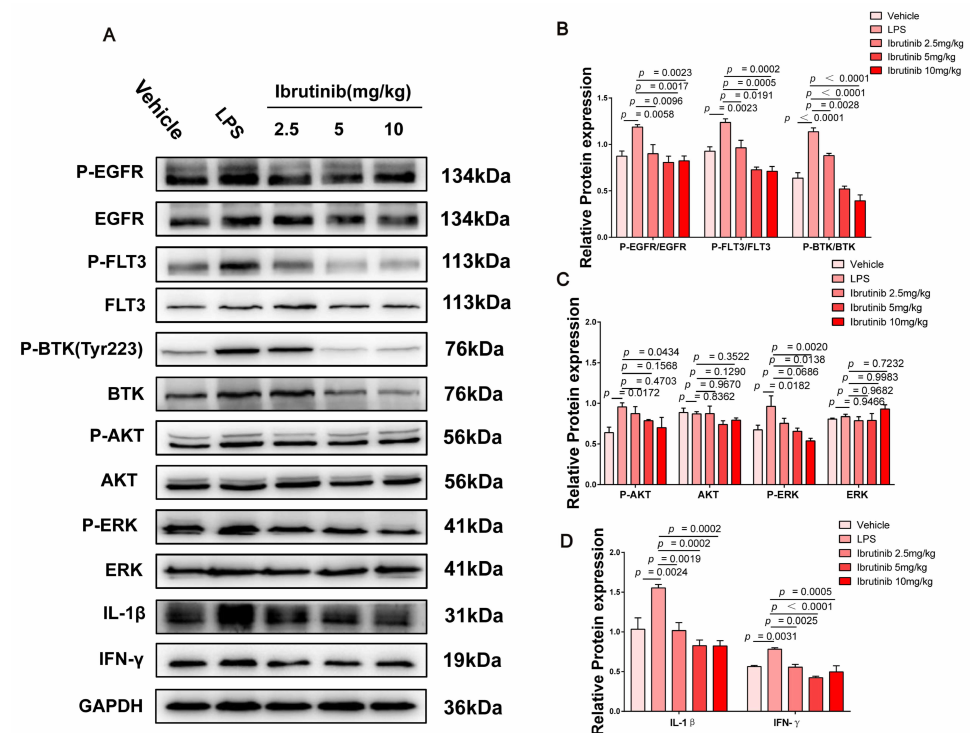
Figure 8. Effects of ibrutinib treatment on the BTK-, FLT3-, and EGFR-related signaling pathways during LPS-induced lung injury. ( A ) Protein levels of P-EGFR, EGFR, P-FLT3, FLT3, P-AKT, AKT, P-ERK, ERK, IL-1 β , and IFN- γ in the whole lung tissues of mice were assessed by Western blot analysis 24 h after LPS stimulation. ( B – D ) Densitometric analysis of the relevant bands (P-EGFR, P-FLT3, and P-BTK normalized to EGFR, FLT3, and BTK). Values are shown as means ± SEM for n =